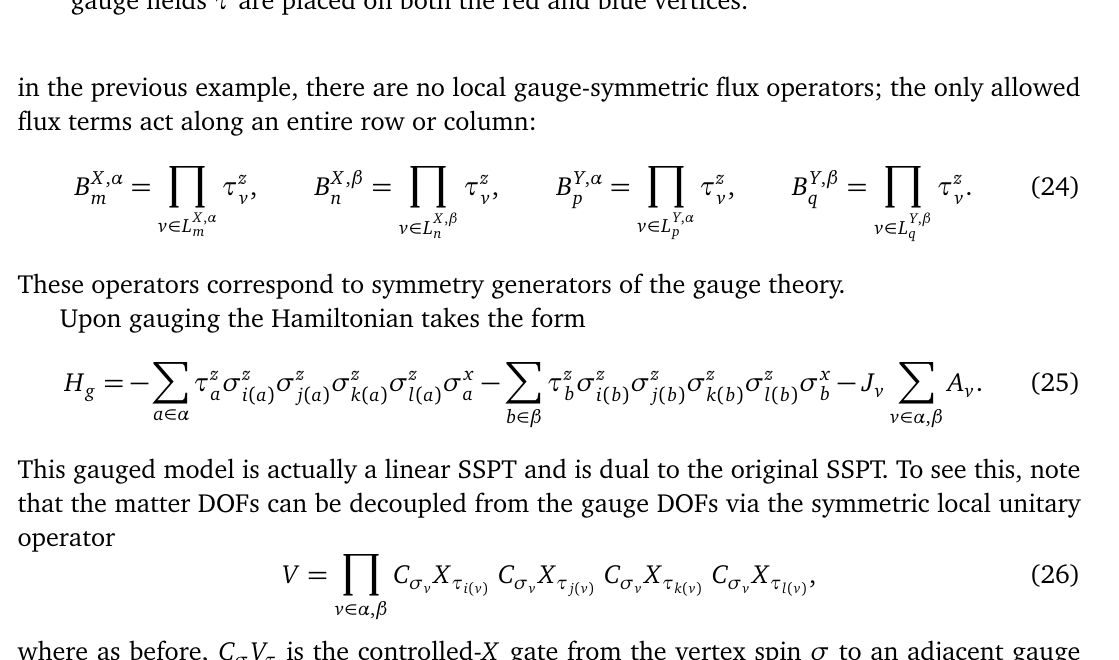
Figure 9: The 2D cluster state model. The two stabilizer terms in Eq. (23) are circled in green above. The black and gray lattices are the α and β lattices. After gauging, gauge fields τ are placed on both the red and blue